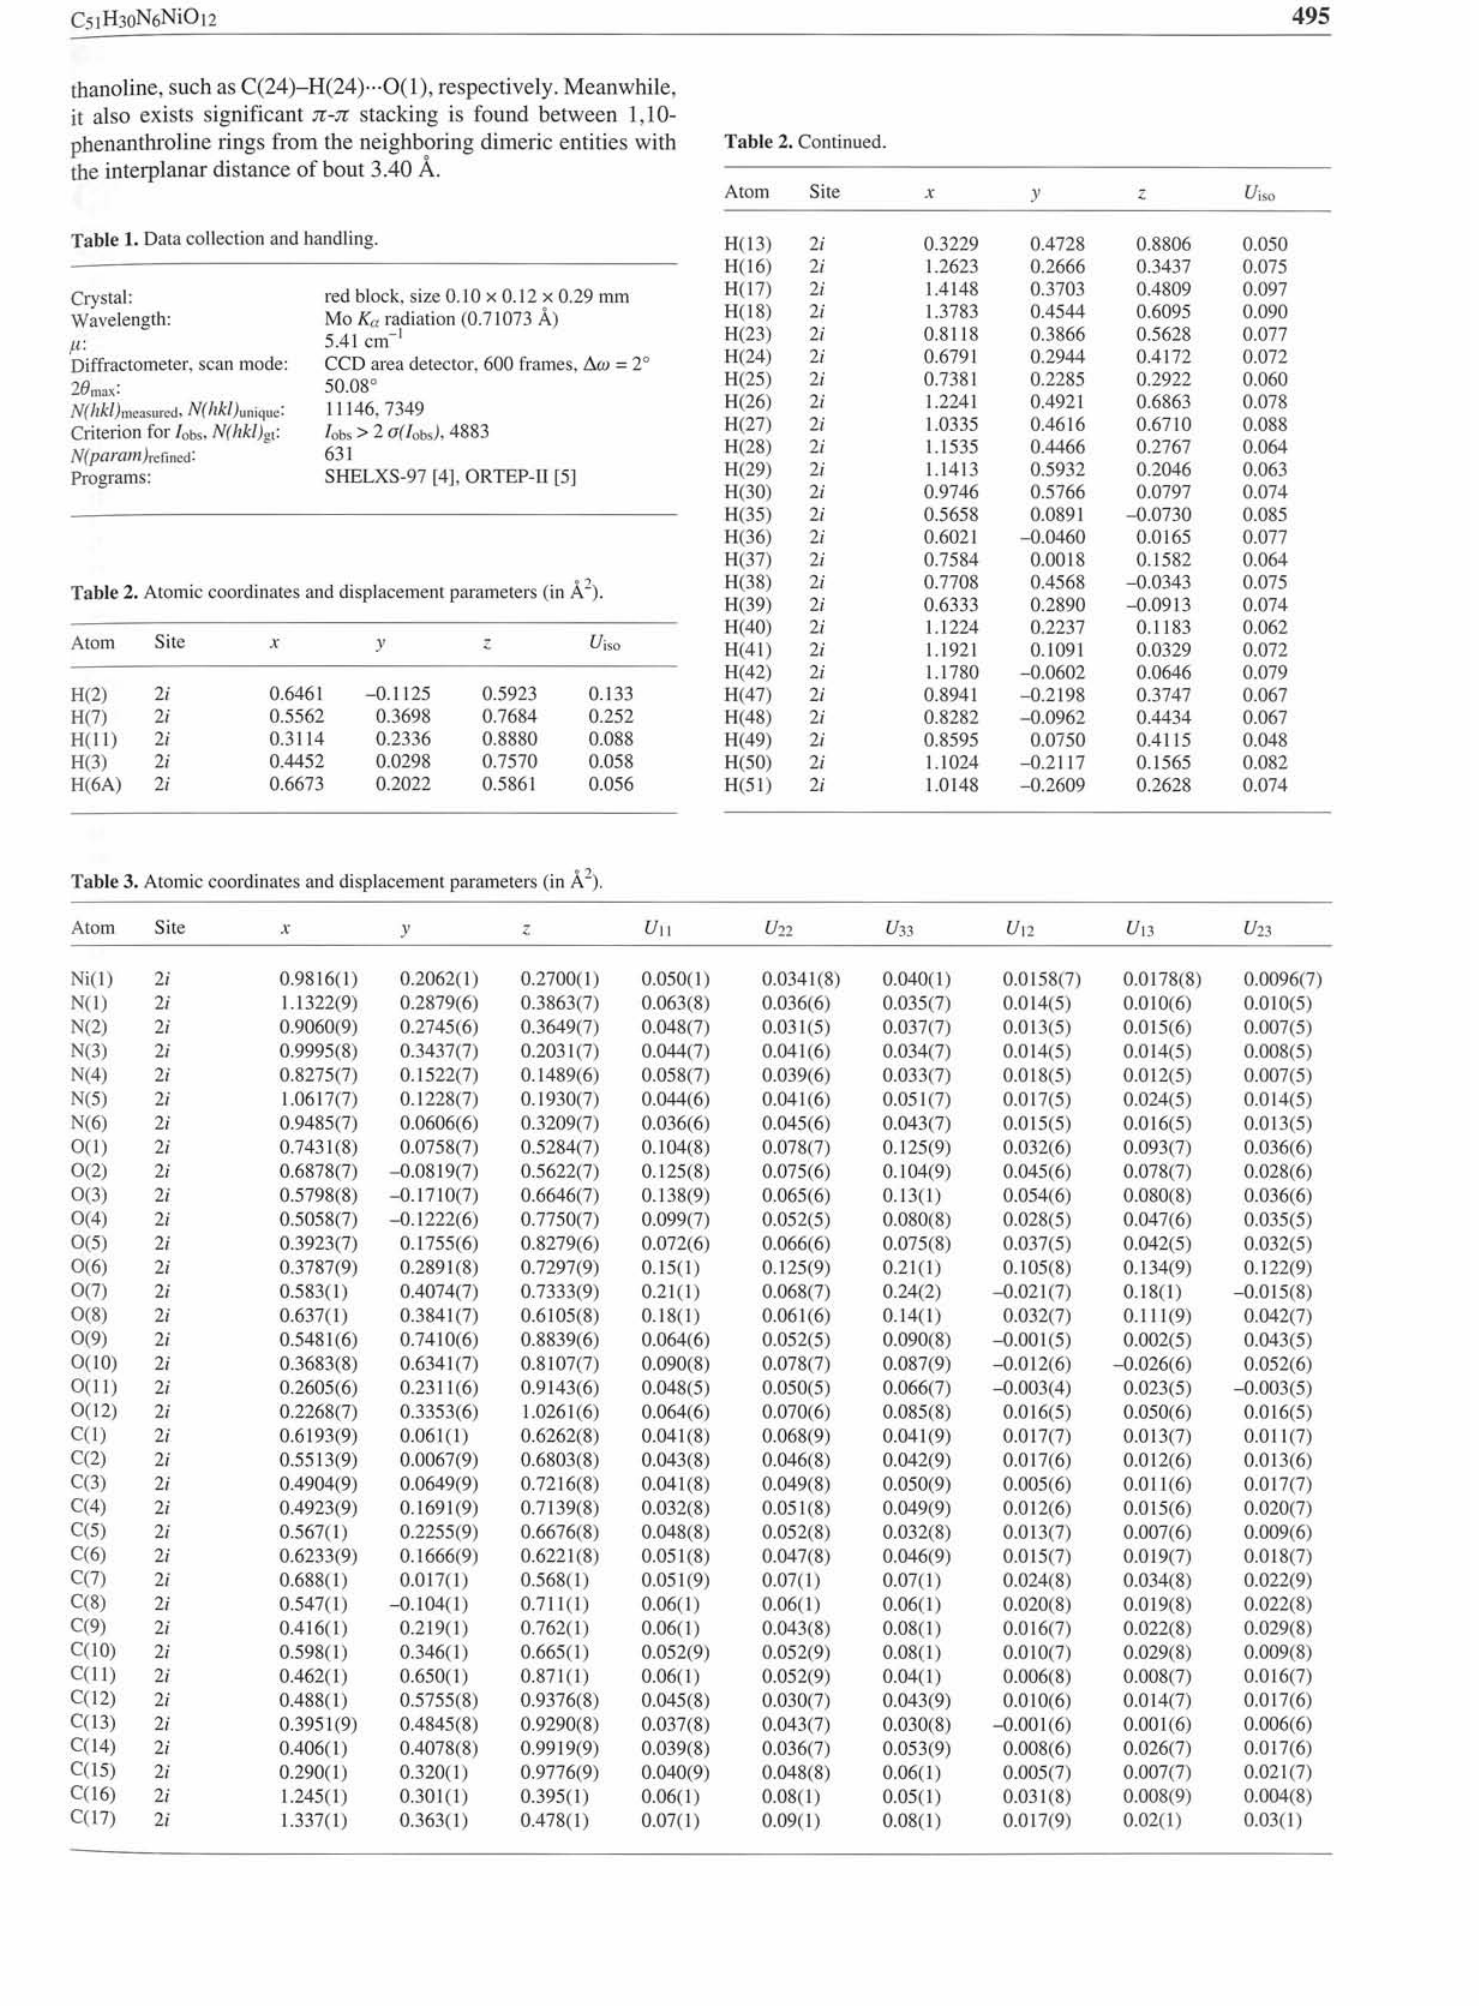
Table 2. Atomic coordinates and displacement parameters (in A").